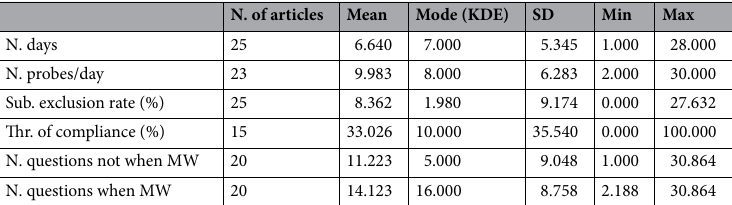
Table 1. Summary of experimental parameters. N. days Number of days (Experiment duration), N. probes/day Expected number of probes per day, Sub. exclusion rate (%) Rate of excluded subjects to recruited subjects, Thr. of compliance (%) Threshold of compliance rate (only if authors used compliance rate as a criterion of subject exclusion), N. questions not when MW Expected number of questions if MW does not exist, N. questions when MW Expected number of questions if MW